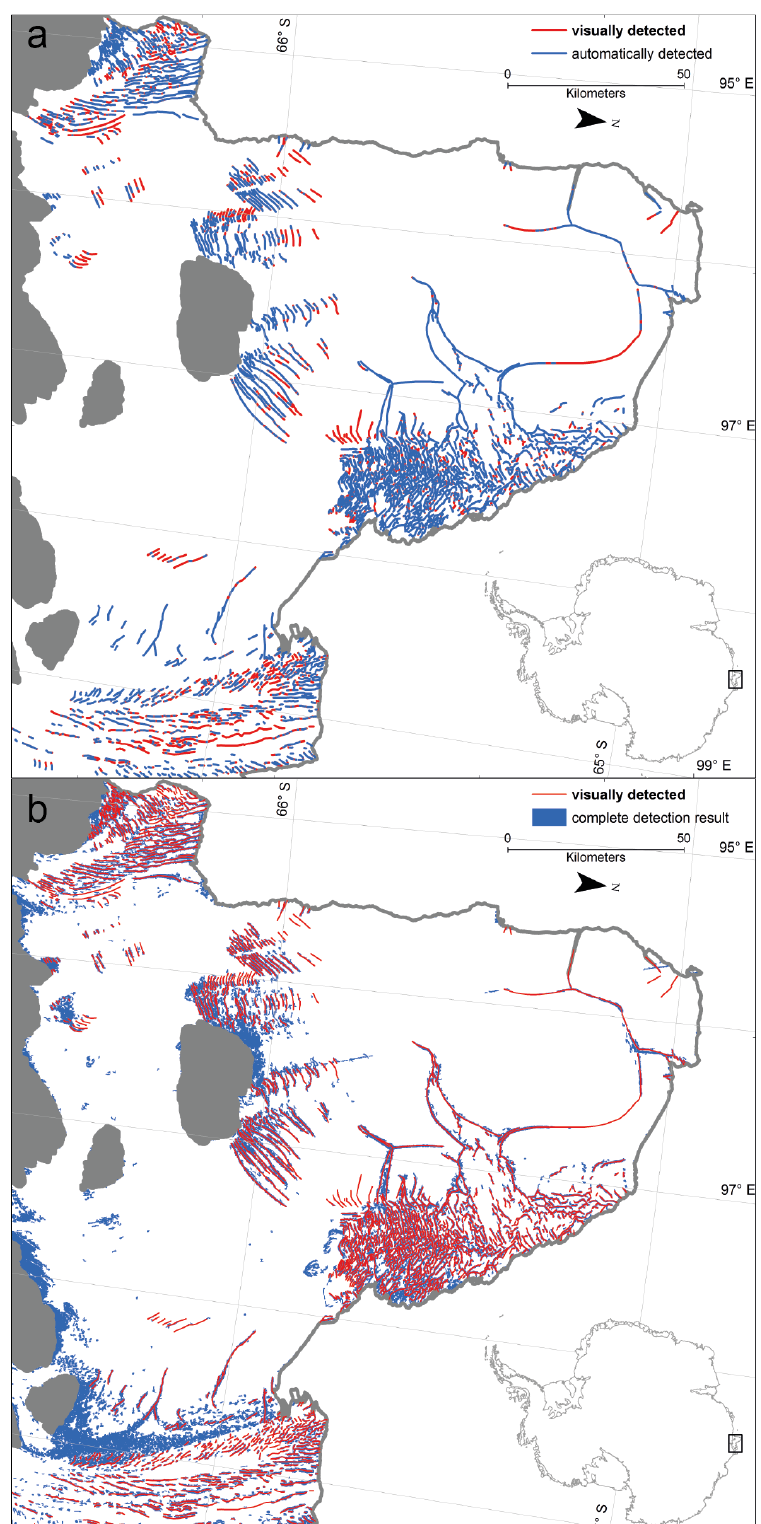
Figure 1. Performance of the automated structure detection on the northern part of the Shackleton Ice Shelf. The blue lines in panel ( a ) show the automatically detected features that match the visually detected features. Red lines indicate where the automated detection failed. A combination of both (red and blue) shows all visually detected surface structures. In panel ( b ) all automatically identified structures including false detection results (blue areas) are compared with the visually detected surface structures (red lines). The grounding line and coastline as well as the islands (all grey) are taken from Haran et al .